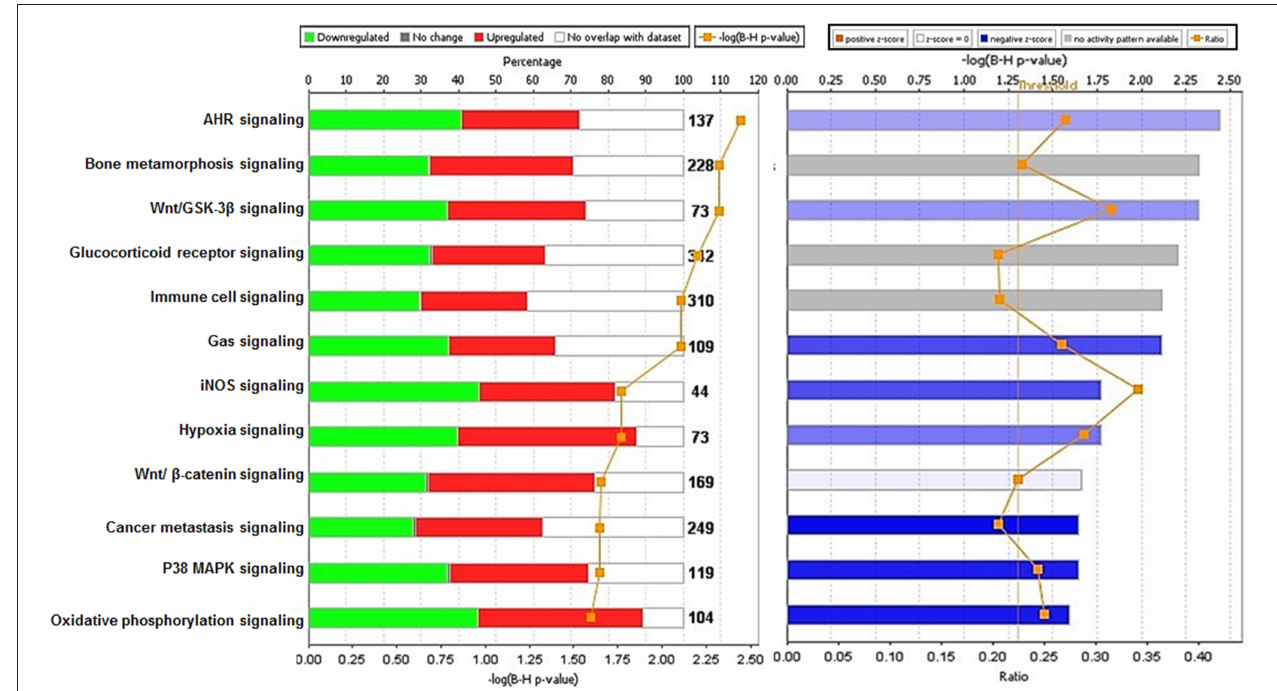
FIGURE 4 | Ingenuity pathway analysis of differentially expressed transcript in TRAMP mice compared with non-transgenic littermates. The stacked bar chart represents the percentage (%) of genes that were upregulated (red), and downregulated (green) and genes not overlapped with TRAMP mouse dataset (white) in each canonical pathway. The numerical value at the top of each bar represents the total number of genes in the canonical pathway. The secondary y-axis (down) shows the –log of P -value calculated by the Benjamini-Hochberg (B-H) method; the B-H method was used to adjust the right-tailed Fisher’s exact test P -value, which indicates the significance of each pathway (left panel graph). The right panel graph calculated z-score indicates a pathway with genes exhibiting decreased mRNA levels (blue bars) or under the state of inhibition (light blue bars). The ratio (orange dots connected by a line) indicates the ratio of genes from the dataset that map to the pathway divided by the total number of genes that map to the same